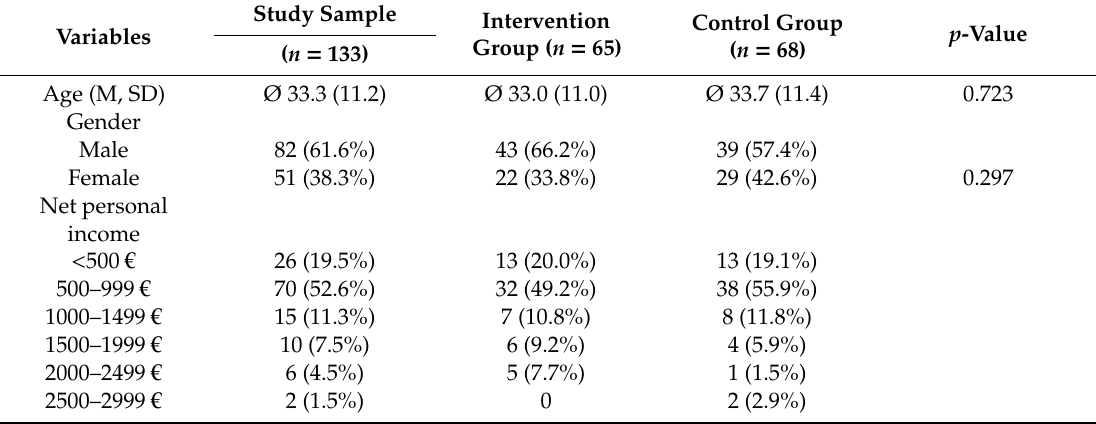
Sociodemographic characteristics of the “Sanadak” study sample with regard to group